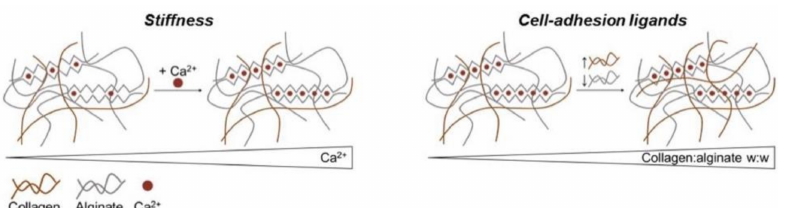
Figure 4. The relationship between the stiffness of composite hydrogel and calcium concentration and the association between collagen concentration and cell-binding sites inside the composite hydrogel. With the increase in Ca 2+ concentration, the stiffness of composite hydrogel will be enhanced. Cell- adhesion ligands also increase as collagen concentration increases. Reproduced from [26] with permission, Copyright (2020)